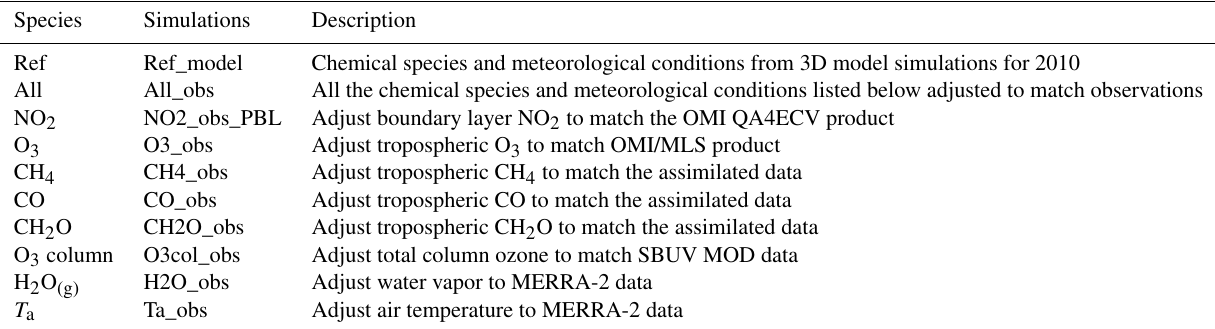
Table 1. The DSMACC model experiments. Species Simulations Description